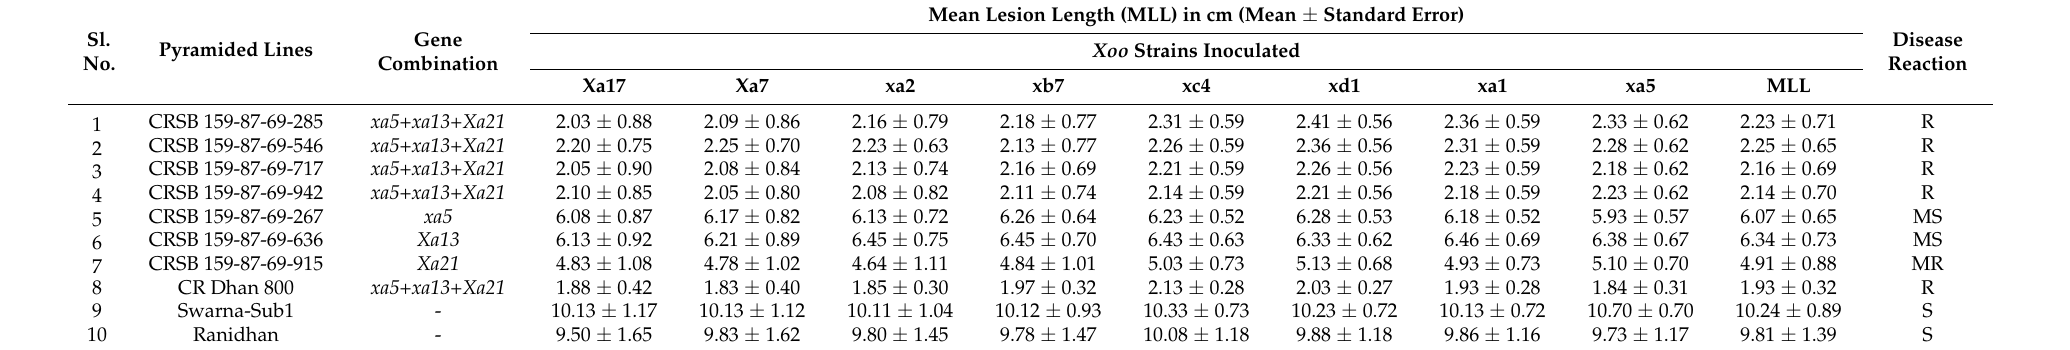
Table 3. Bacterial blight disease score and reaction of the pyramided and parental lines to different Xoo inoculated strains during the wet seasons of 2020 and 2021. Sl.